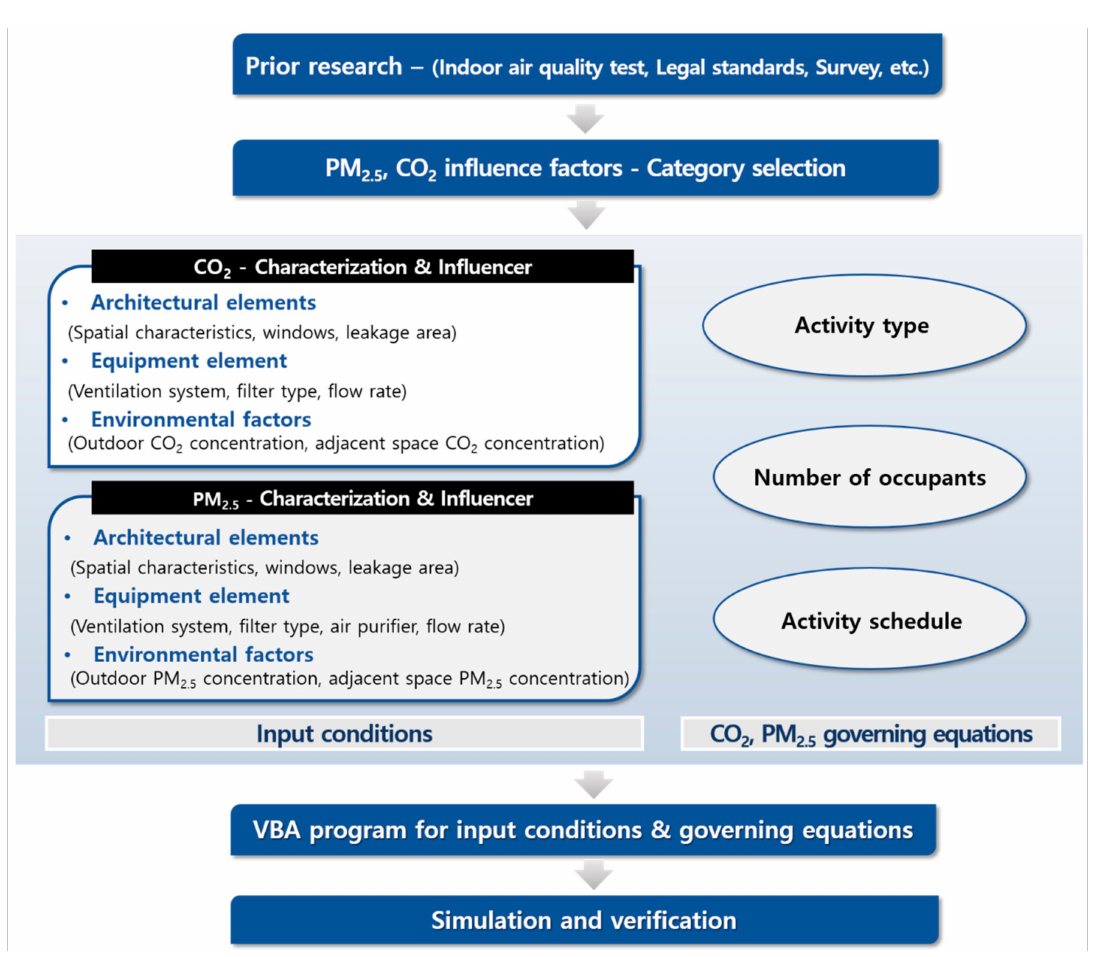
Figure 3. The research model regarding the indoor air quality diagnosis program for office and multipurpose activity spaces at